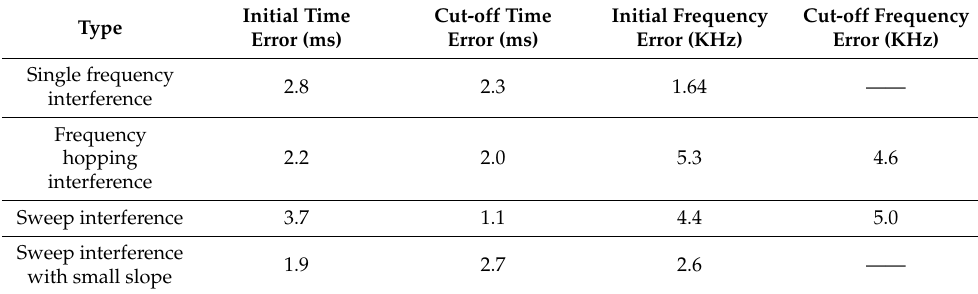
Table 2. Root mean square error of interference identification parameter test.